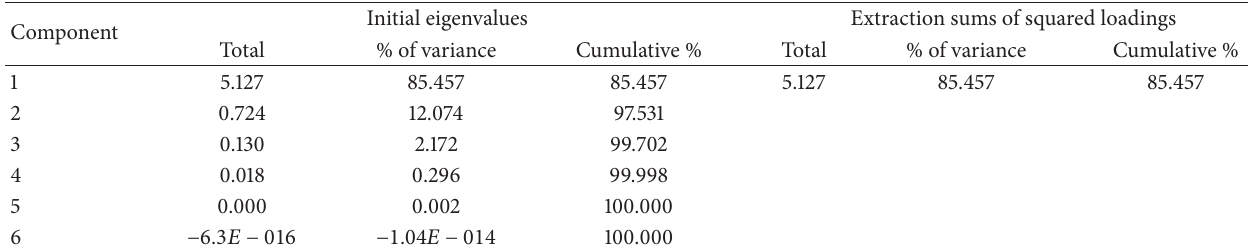
Table 5: Total variance explained.